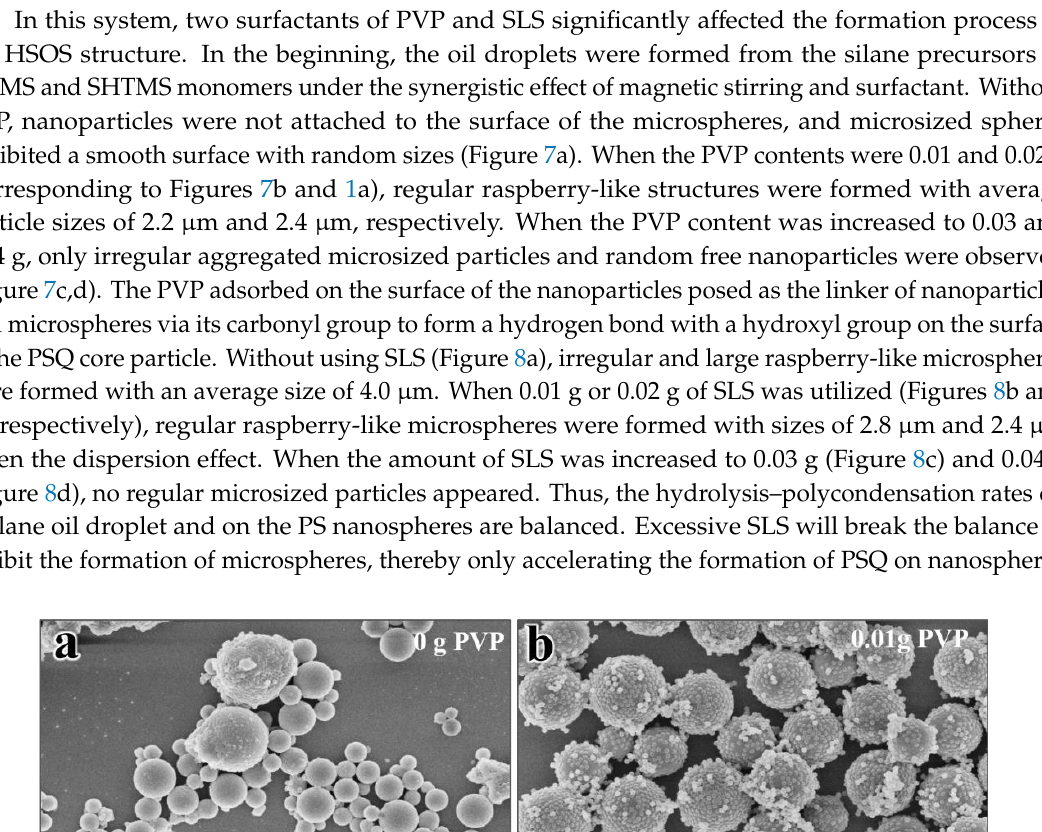
Figure 8. Effects of SLS contents on the SEM images of HSOS particles; ( a ) 0 g, ( b ) 0.01 g, ( c ) 0.03 g, ( d ) 0.04 g. 3.7. Au@HSOSs for Catalyst Reduction of 4-NP